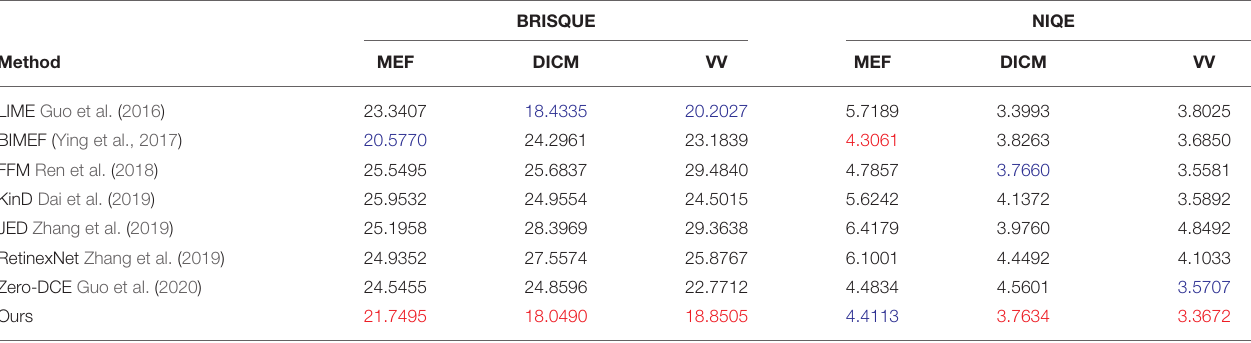
TABLE 3 | BRISQUE and NIQE quantitative evaluations of the public datasets MEF, DICM, VV, and LIME, with the best results labeled in red font and the second best results labeled in